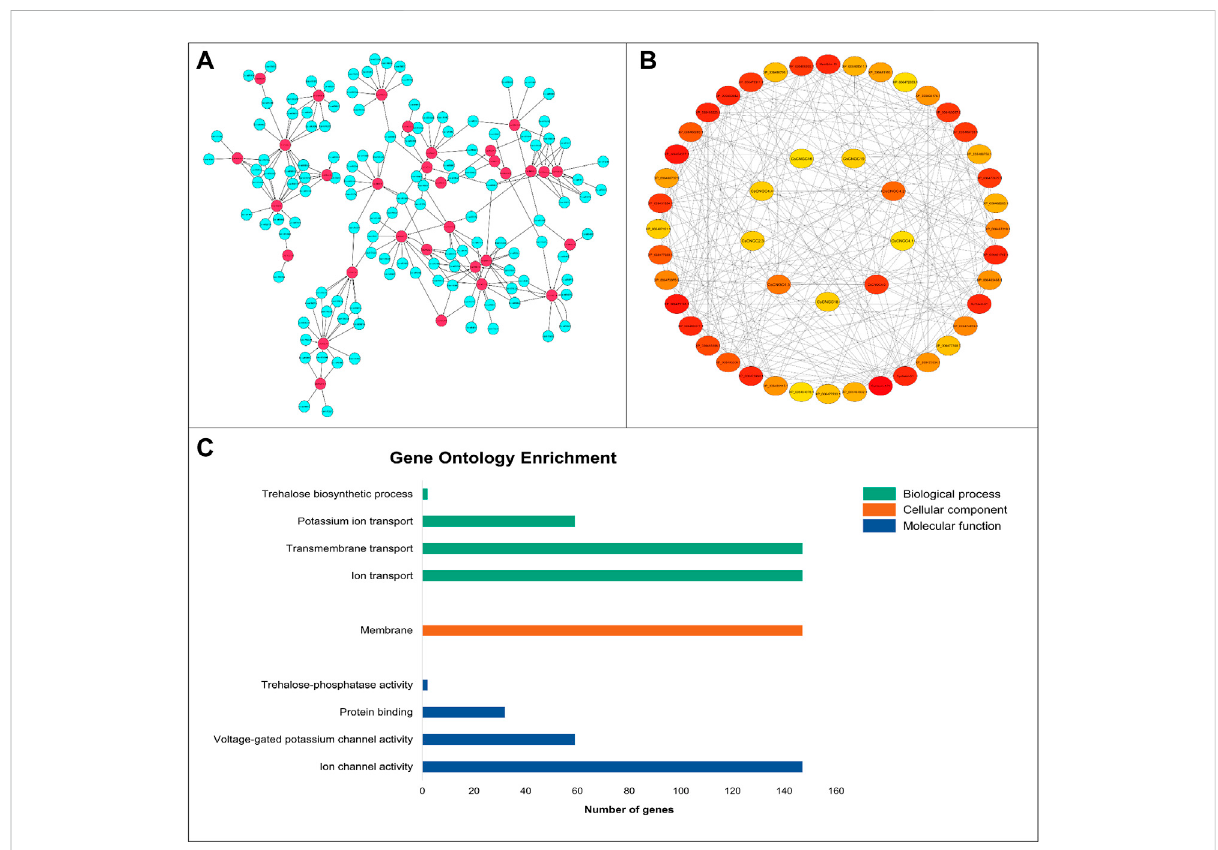
FIGURE 7 (A) Network representation of regulatory association among miRNAs and CsCNGCs . The network has been constructed by using Cytoscape. The miRNAs involved in regulating CsCNGCs are colored blue. CsCNGC genes are colored red and black colored lines represent the regulatory relationship. (B) Network showing the interactions among CsCNGCs and other protein members predicted using STRING database. The nodes are colored according to the degree of interactions. The red color is showing the protein has a higher level of connectivity with other members, orange-colored nodes have a relatively lesser level of interactions with other proteins while yellow-colored nodes have the least interactions with otherproteins. (C) Geneontologyenrichmentstatisticsgraph,thegreencolorbarrepresentsbiologicalprocesses,theorangecolorbarrepresentsa cellular component, and the blue color bar represents the molecular